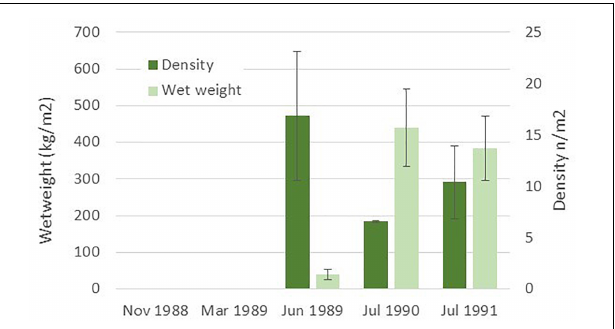
FIGURE 4 | Recruitment of sugar kelp ( S. latissima ) to an isolated island where sea urchins were removed during autumn 1988 and spring 1989 (data from Table 1 in Leinaas and Christie,